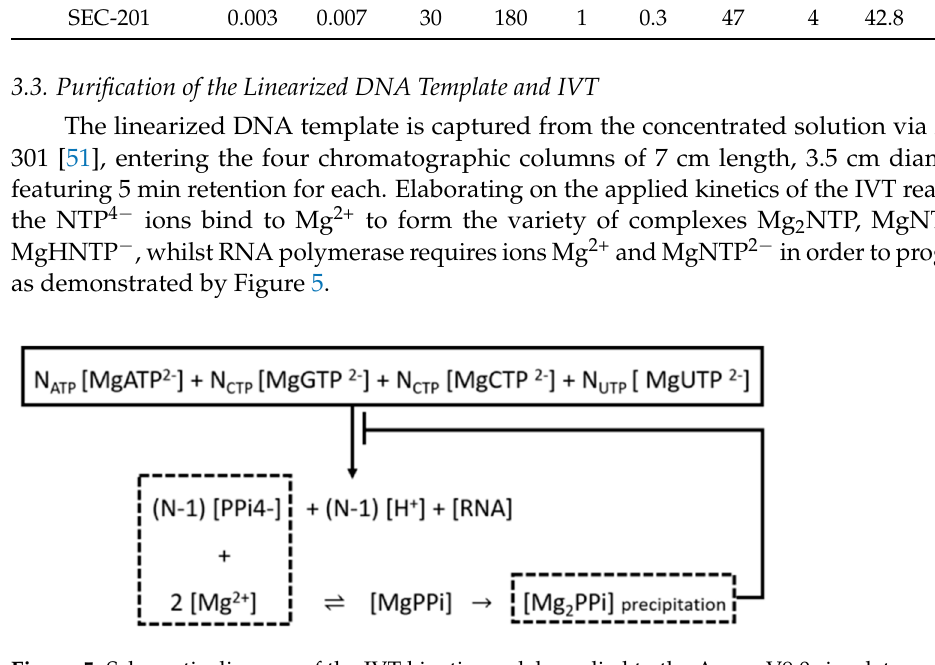
Table 6. ANOVA of RNA production rate exploring the design space of the factorials polymerase and UTP concentration.